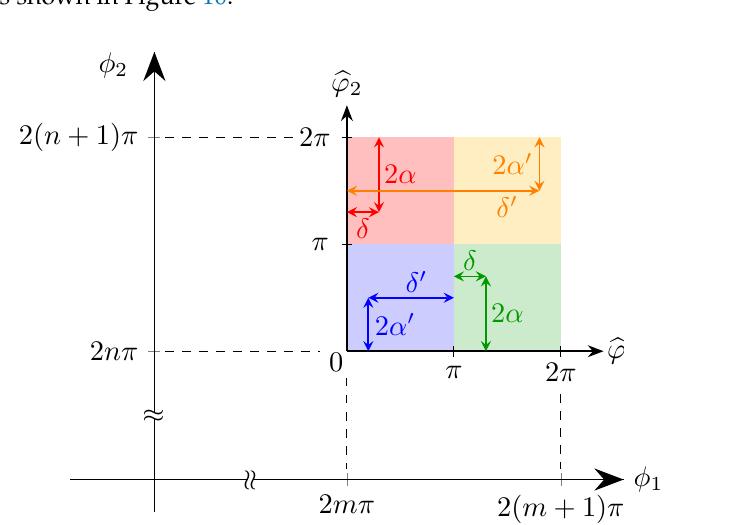
Figure 10. Diagram for the determination of the input SOP: φ 1 and φ 2 are the actual applied phase shifts, ϕ 1 and ϕ 2 are the remainders; the new origin is placed in ( 2 m π ,2 n π ) . The top quadrants whereas (shaded in red and yellow) correspond to the first solution, ( φ (cid:48) (cid:99) (cid:99) green) to the second solution. Polarisations with the same value of δ lie in diametrically opposed quadrants: the red and green concern the case of δ ( π ,2 π ) δ ∈